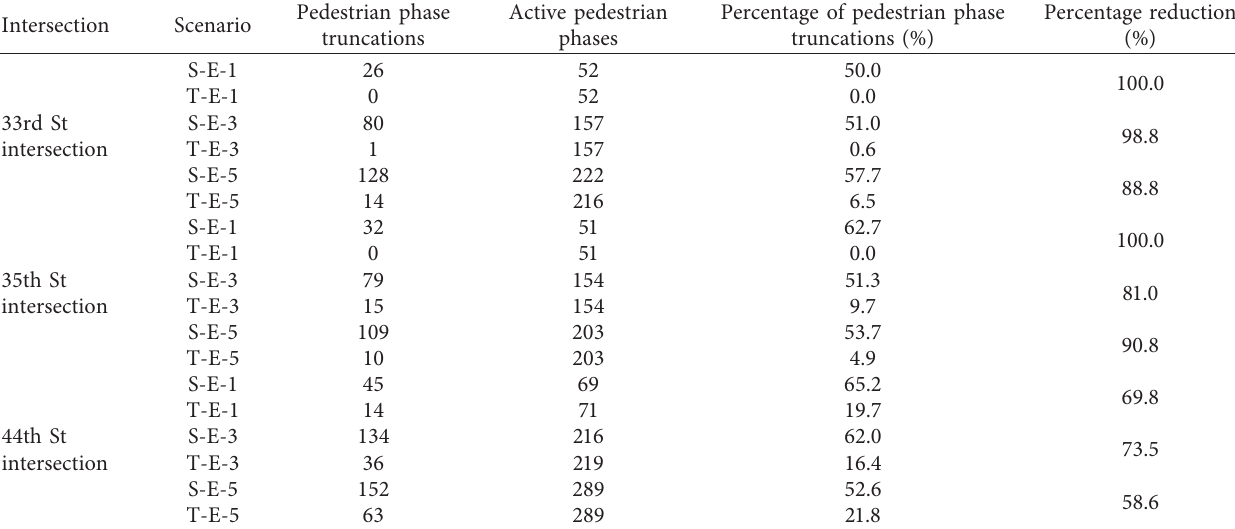
Table 6: Pedestrian phase cutoffs for the scenarios with trains in both directions.